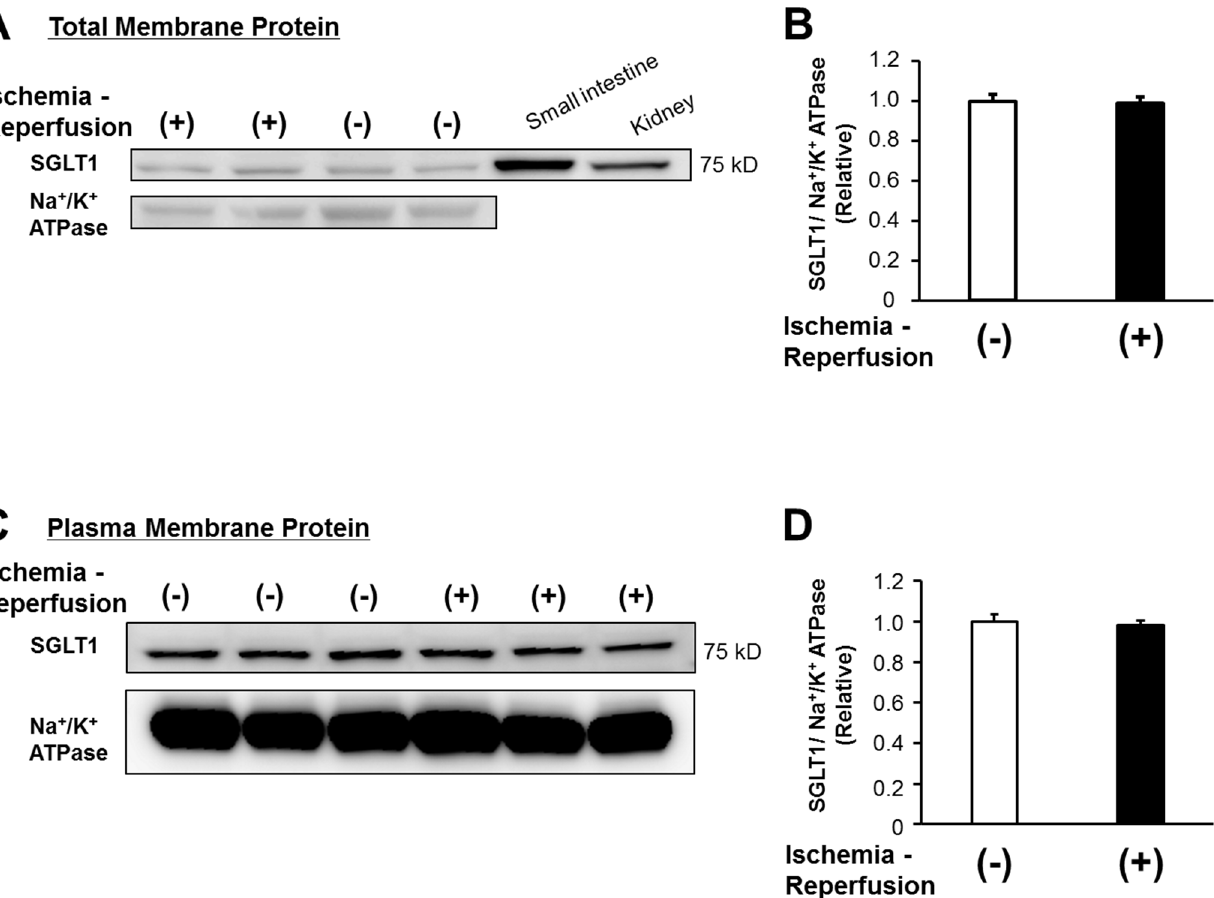
Fig 3. SGLT1 is expressed in the murine perfused hearts. (A) Representative immunoblots of SGLT1 in the total membrane fraction from the murine perfused hearts treated with or without ischemia-reperfusion are shown. Total lysates extracted from the murine small intestine and kidney were immunoblotted as positive controls. (B) Densitometric quantitation normalized to the level of control perfused hearts without ischemia-reperfusion is shown (n = 3 each). (C) Immunoblots of SGLT1 in the plasma membrane fraction from the murine perfused hearts with or without ischemia-reperfusion are shown. (D) Densitometric quantitation normalized to the level of control perfused hearts without ischemia-reperfusion is shown (n = 3 each). In both (A) and (C), immunoblots of Na + /K + ATPase from the same membrane are shown as a loading control for the membrane fraction.